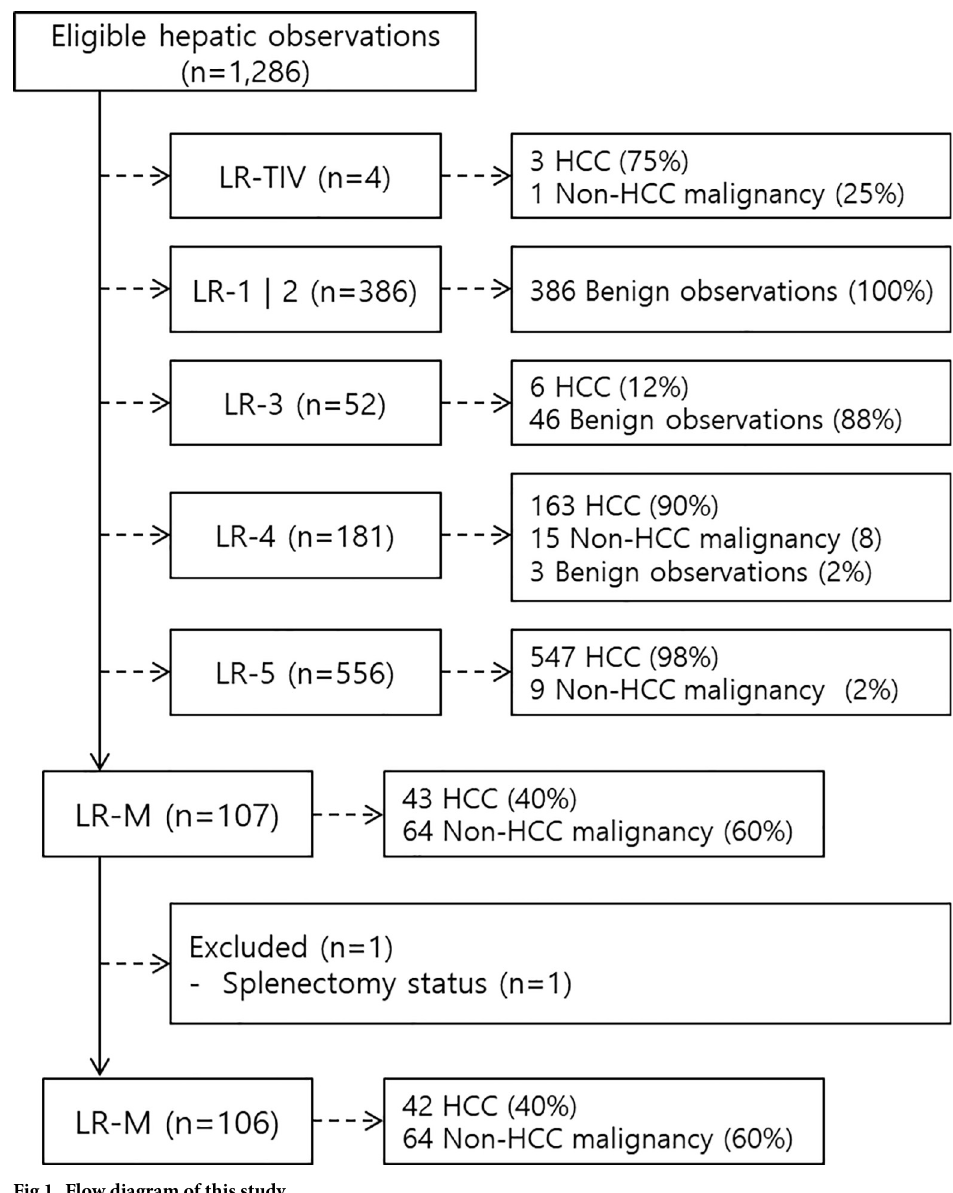
Fig 1. Flow diagram of this